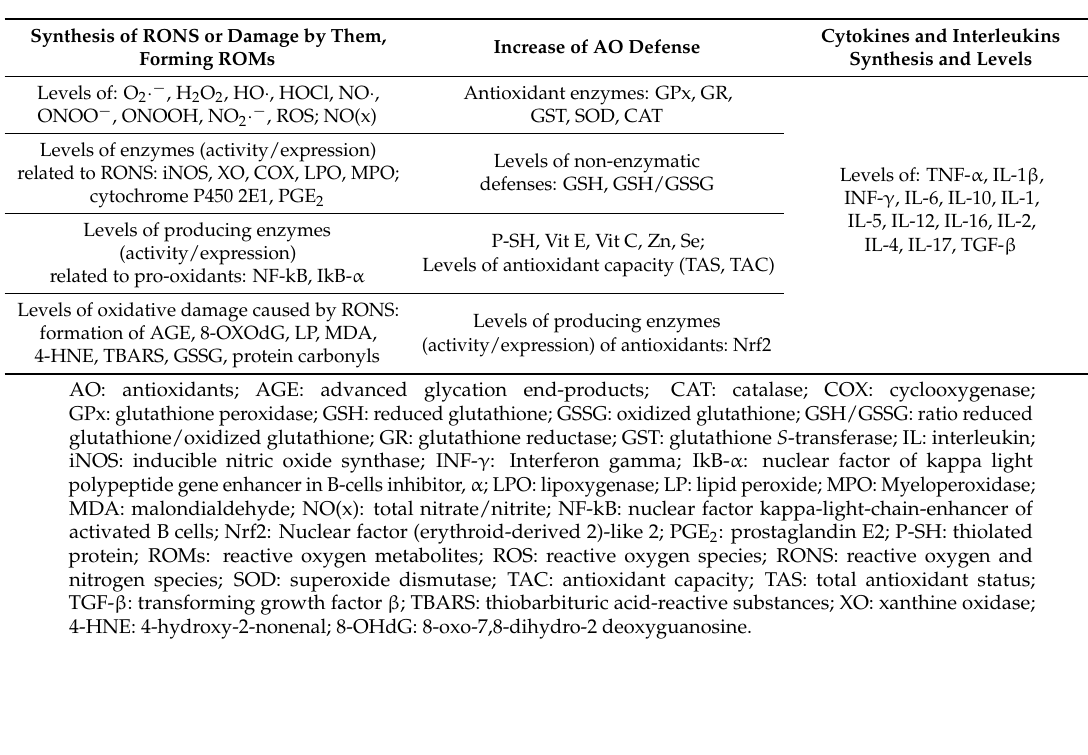
Cytokines and Interleukins Synthesis and